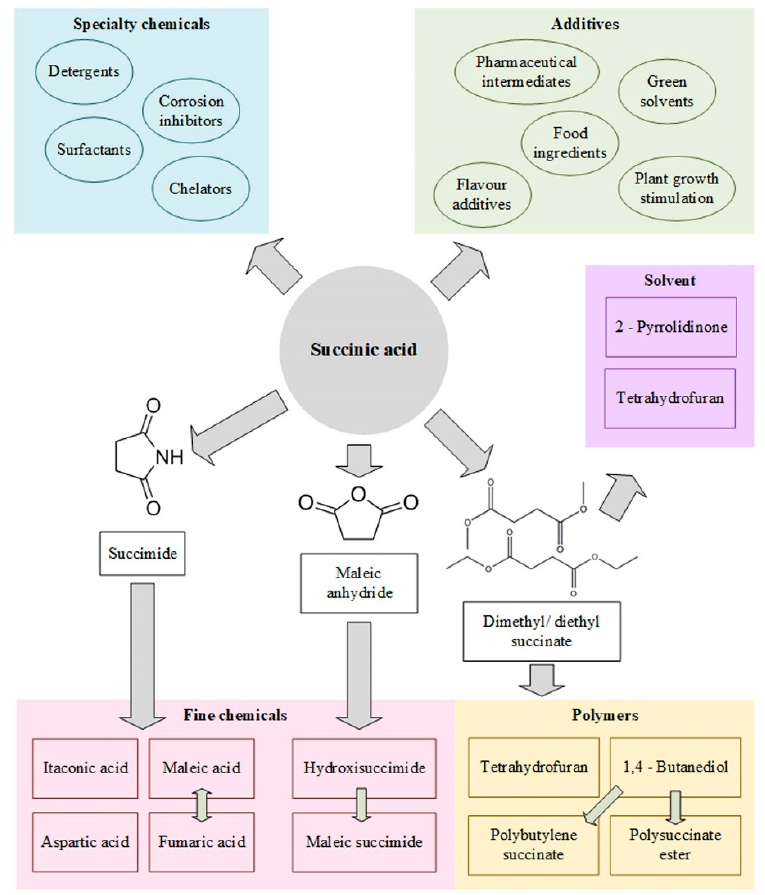
Figure 1. Array of intermediate and end products stemming from succinic acid .